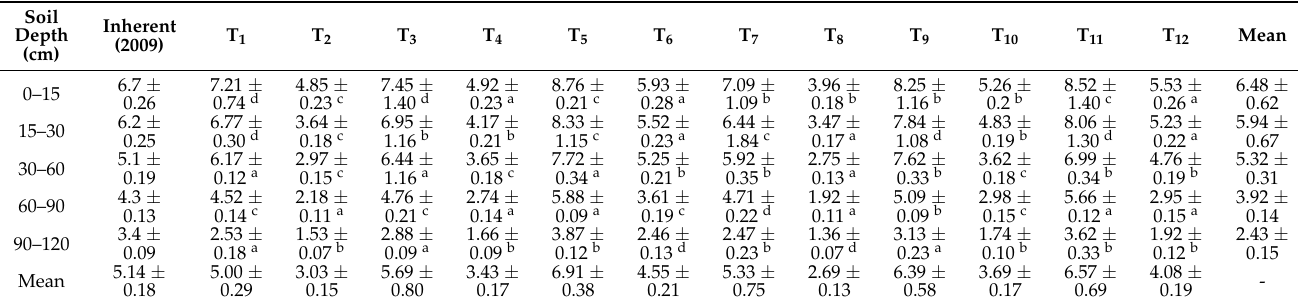
Table 5. After 6 years, changes in soil organic carbon (SOC) concentration (g kg –1 ) under alternative agricultural systems and precision land levelling